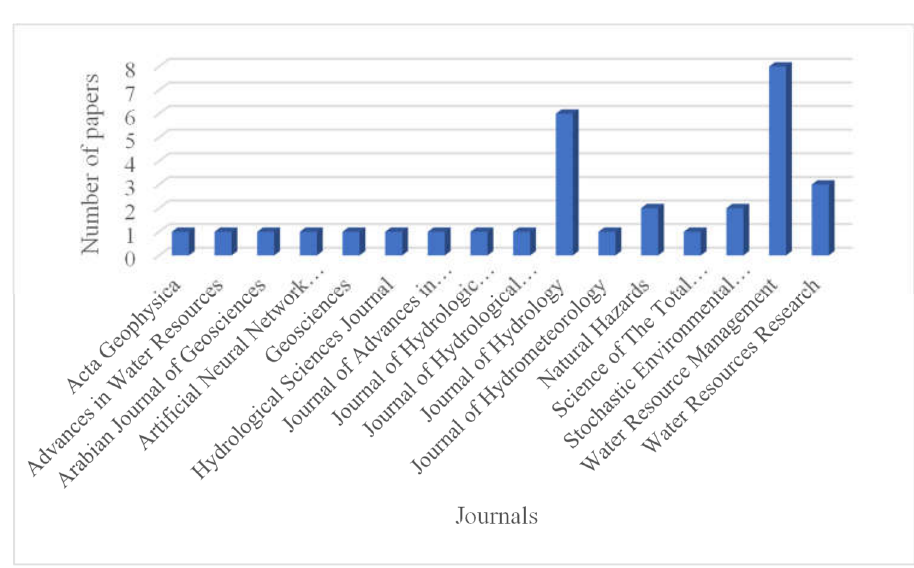
Figure 7. Distribution of articles in different journals.